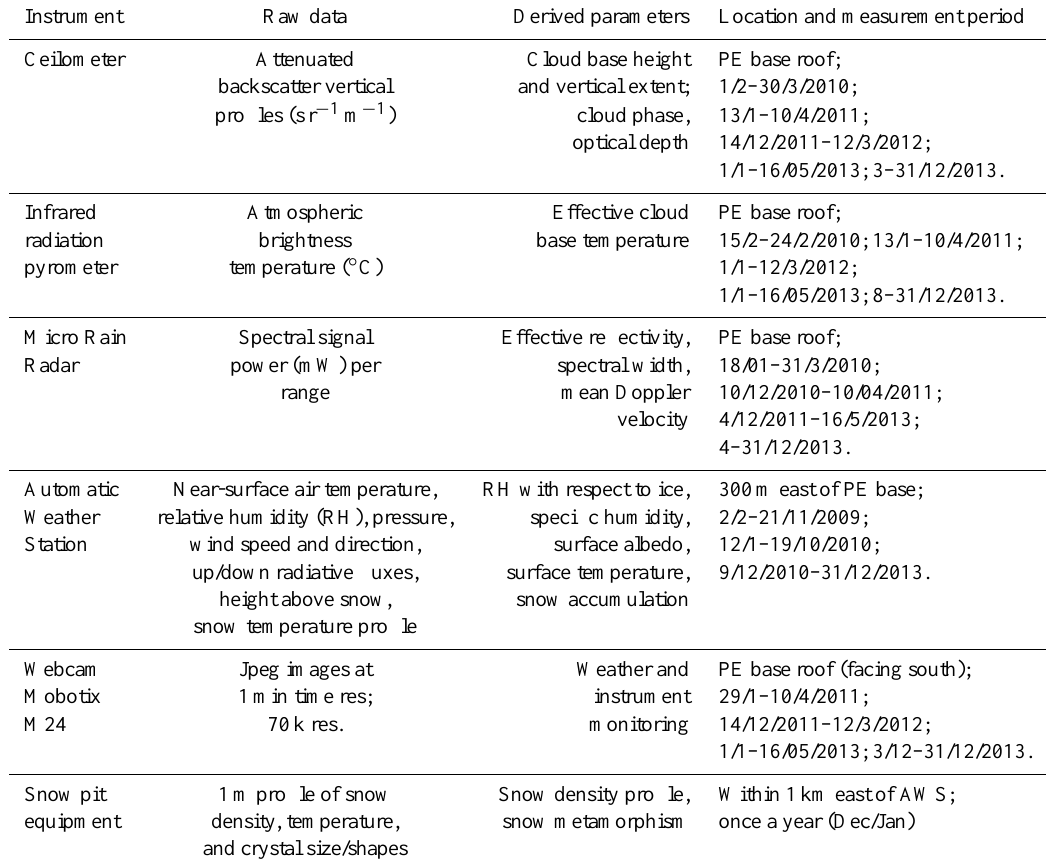
Table 1. Overview of the HYDRANT instruments: raw measured data, derived parameters, location and continuous measurement periods used for analysis (with data gaps < 3 days) until 31 December